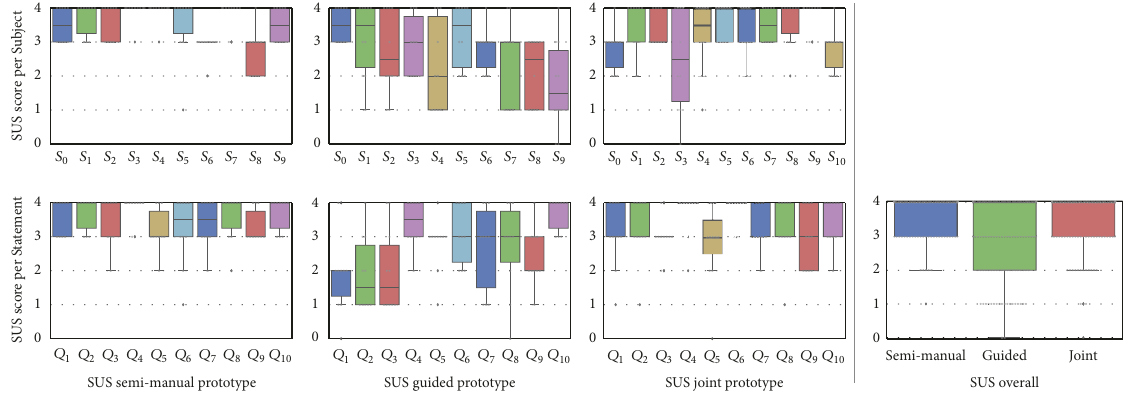
Figure 9: Results of the SUS questionnaires per prototype. Values are normalized in accordance with Equation (5), such that 4 is considered the best possible result for each question. The semi-manual prototype’s SUS mean is 88 , guided prototype’s mean is 67 , and joint prototype’s mean SUS score is 82